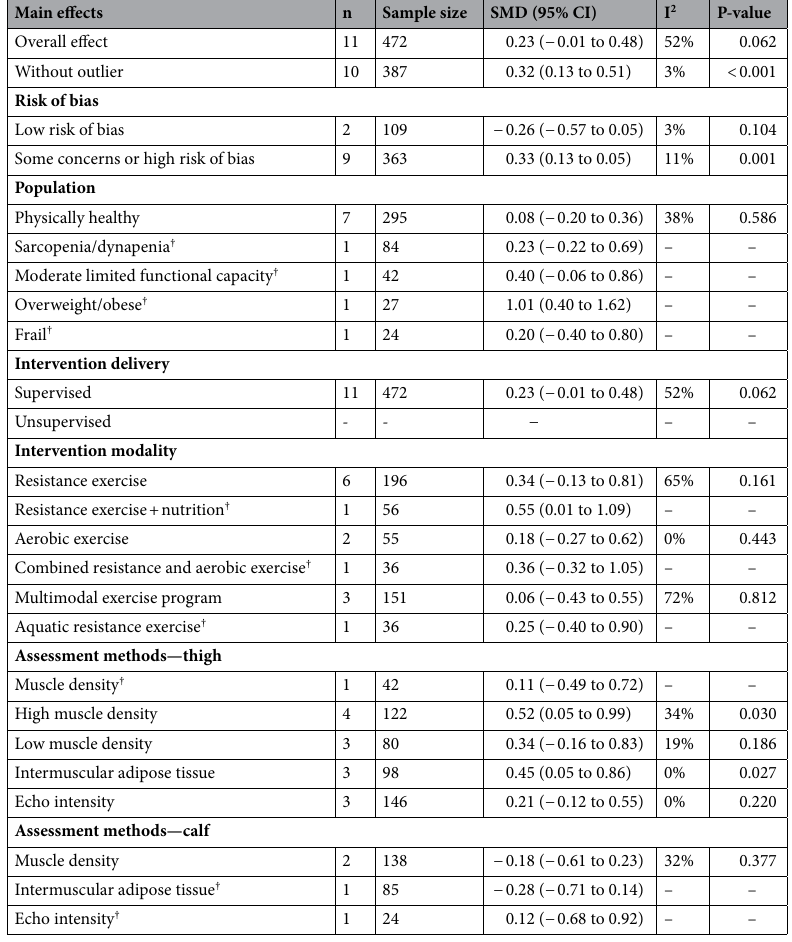
Table 2. Overall and subgroup exercise effects on MQ derived from morphological outcomes in older adults. † Insufficient data for analysis; I 2 , indicator of between-study heterogeneity; n, number of studies; SMD, standardised mean